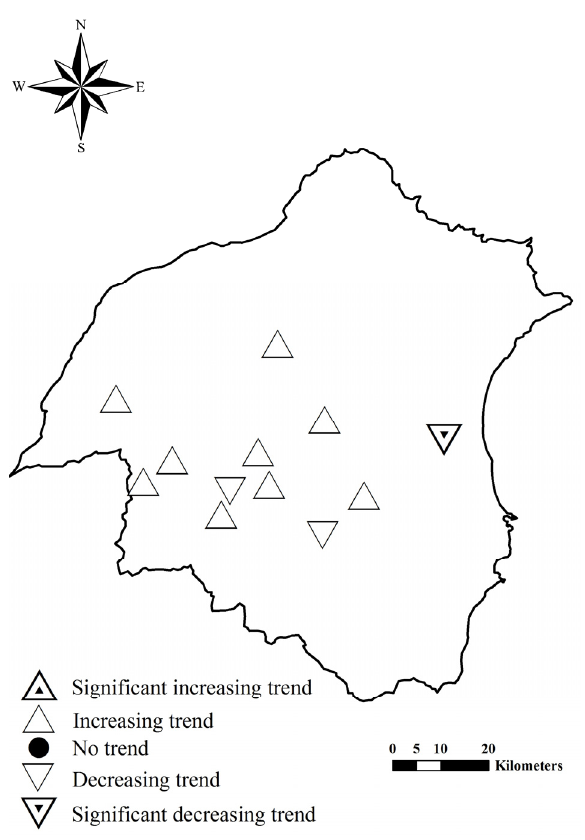
Figure 2. Map showing spatial variation in trends in annual mean flows.